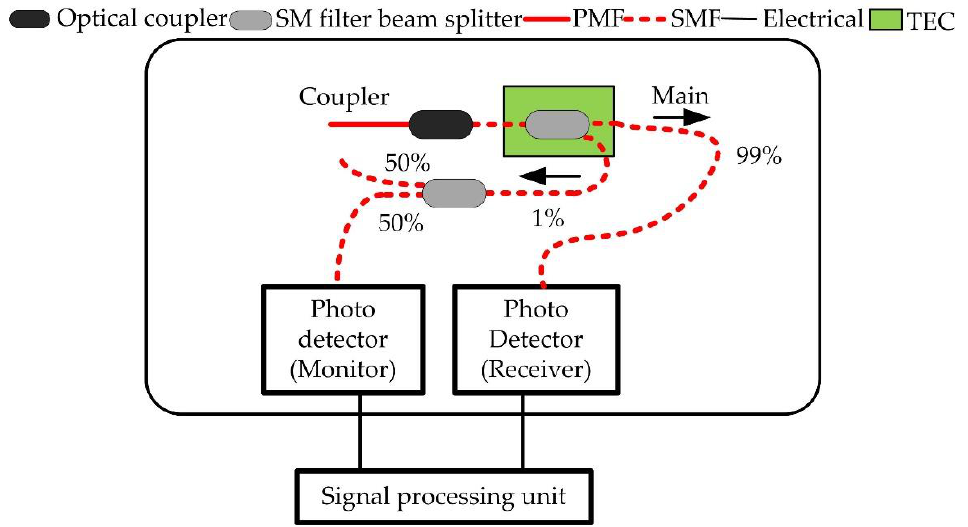
Figure 4. Same experimental setup as Figure 3, but a TEC was added to the SM filter beam splitter.